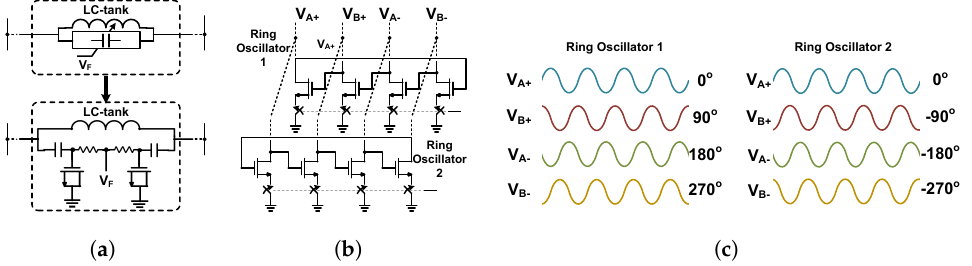
Figure 2. ( a ) Tunable LC-tank circuit with ac-coupled NMOS varactor, ( b ) ring oscillators for phase lead/lag selection, and ( c ) oscillator generated output waveforms for different ring oscillator configurations.